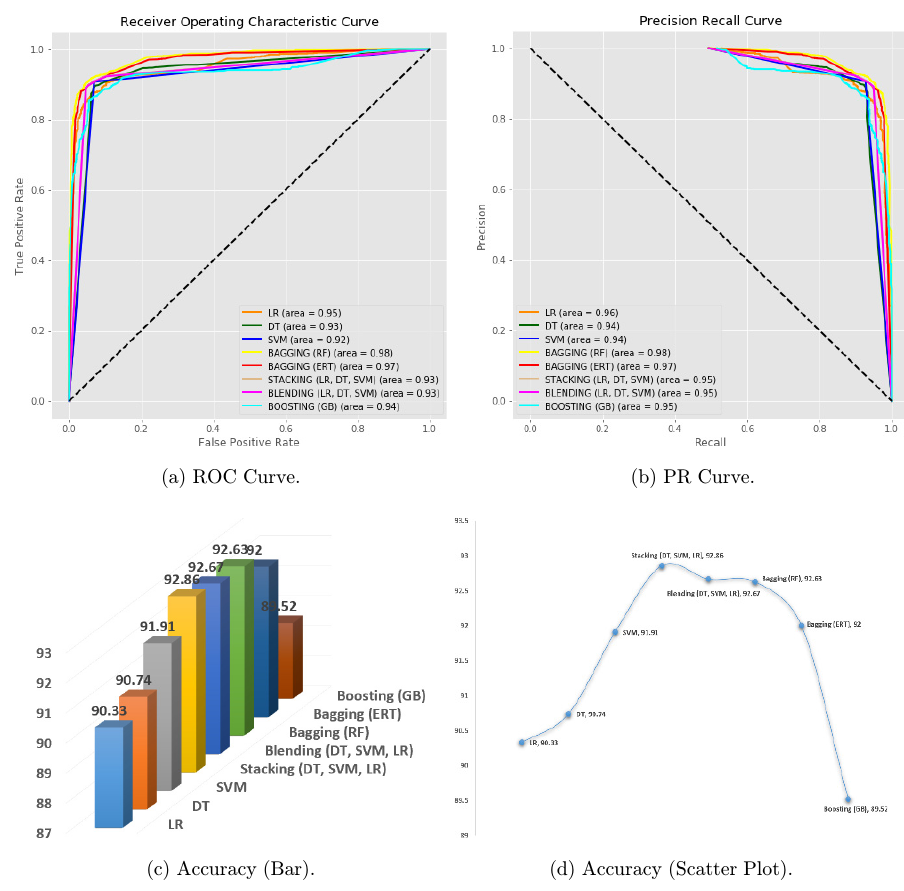
Fig. 2. Three words as Substring (model